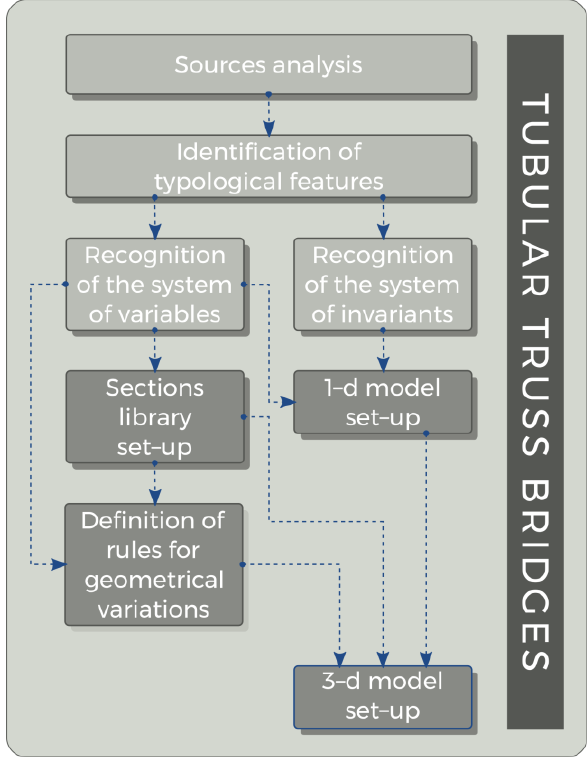
Figure 2 . The layout of phases proposed in the